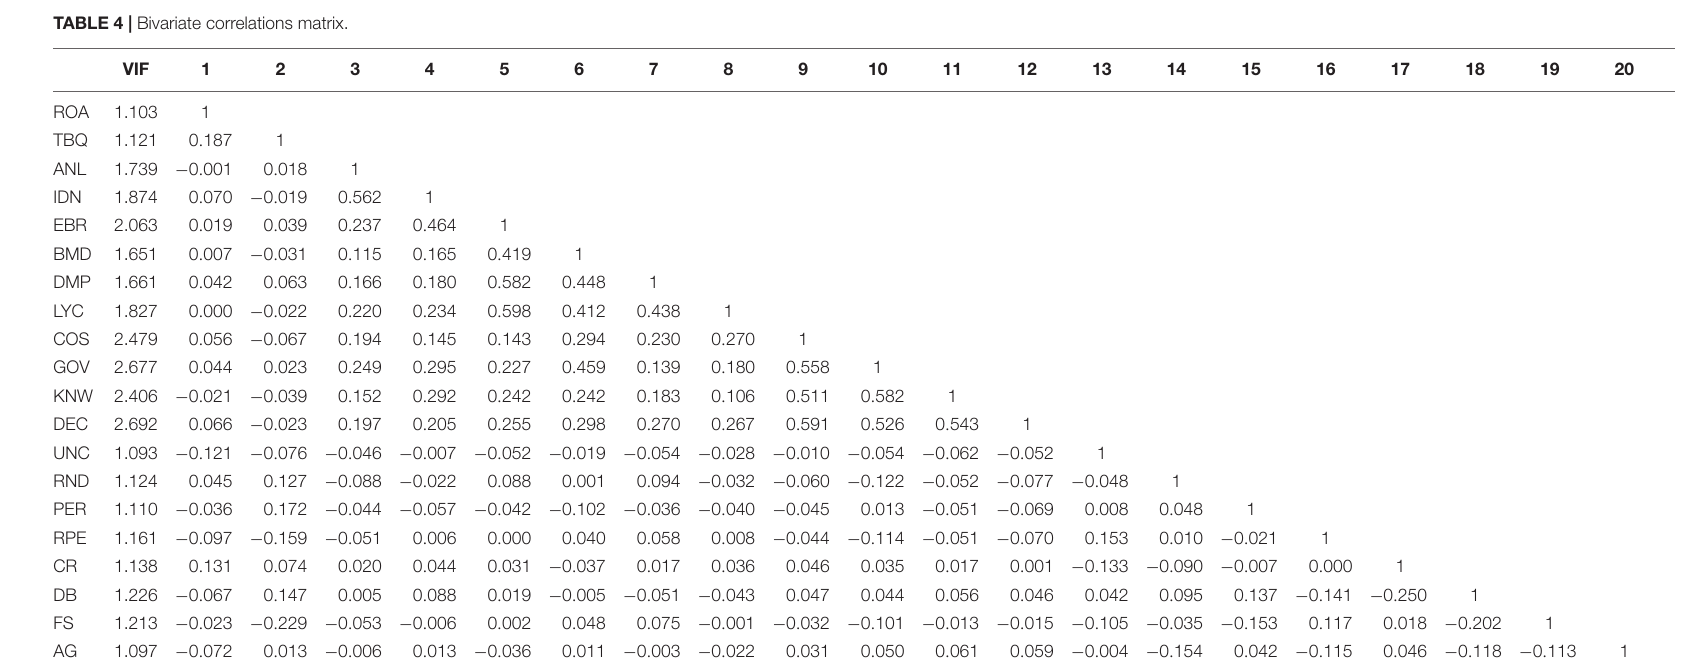
ROA, return on assets; TBQ, Tobin’s Q; ANL, analyzing; IDN, identifying; EBR, enterprise boundaries; BMD, business model design; DMP, decision-making protocols; LYC, loyalty and commitment; COS, cospecialization; GOV, governance; KNW, knowledge management; DEC, decentralization; UNC, uncertainty; RND, R&D intensity; PER, price earnings ratio; RPE, revenue per employee; CR, current ratio; DB, debt ratio; FS, firm size; AG, firm